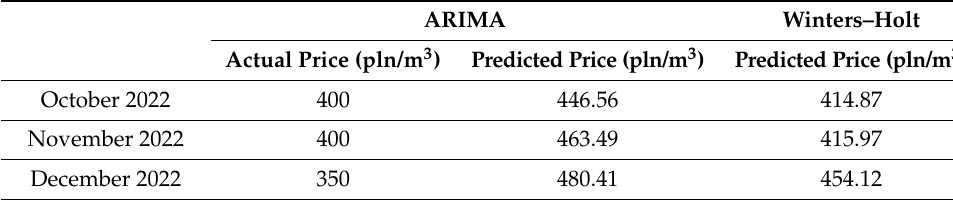
Table 5. Lumber wood chip price prediction for October–December 2022.